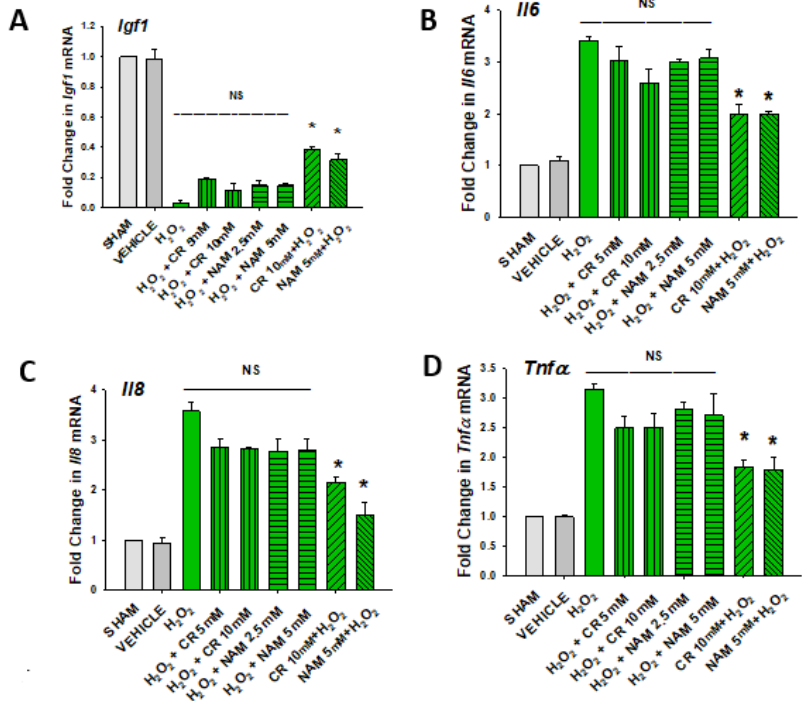
Figure 7. Effect of Cr and NAM posttreatment on oxidant induced IGF-1 and SASP mRNA expression. DHF were treated as in Figure 6, and IGF-1 or SASP cytokines measured ( A – D ). The data are mean ± SE from triplicate experiments. Data sets of SASP cytokines were quantified using the Livak method and normalized to sham. * Denotes statistically significant changes in the Cr/NAM treated levels in comparison to H 2 O 2 alone. NS, the treatments compared are not statistically significantly different.